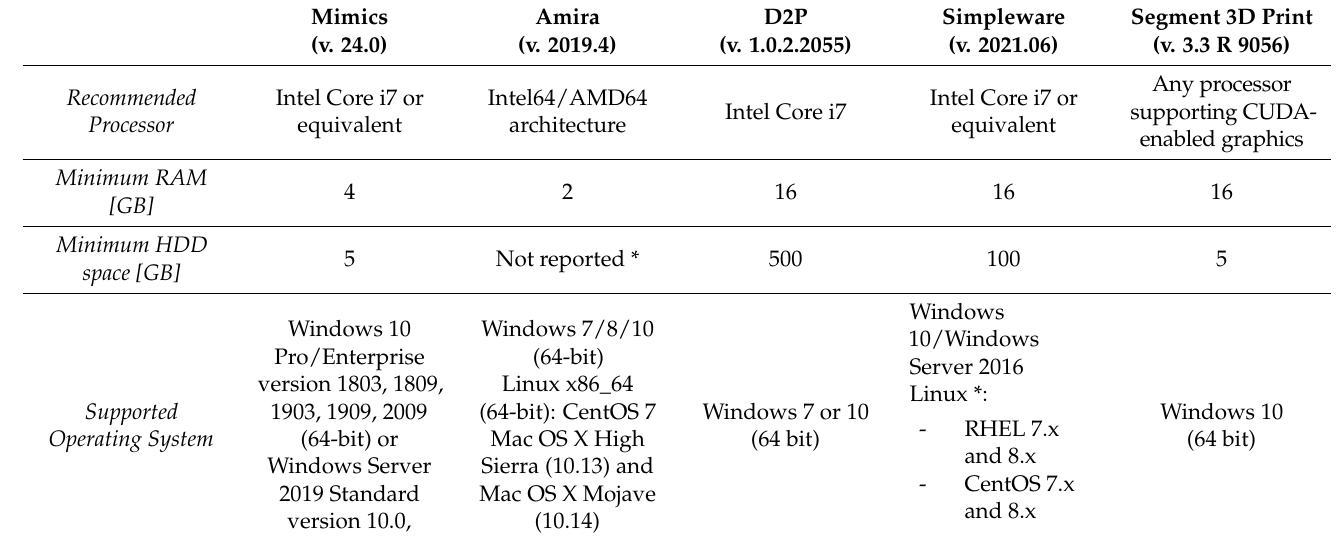
Table 1. Technical requirements for each software package analyzed (* for best performance, multiple hard drive configuration—3 or more HDDs or SSDs—in RAID 5 mode is recommended, as reported in relevant user